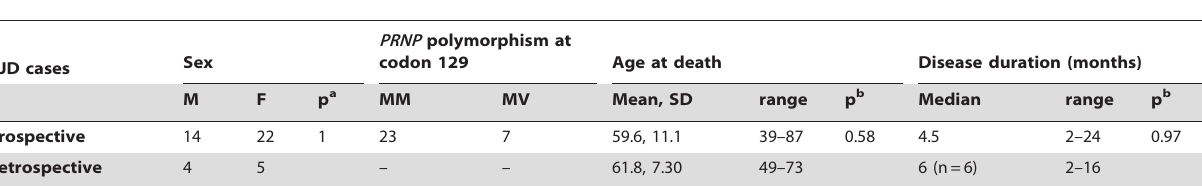
Table 2. Demographic and clinical characteristics of E200K CJD patients included in the study.